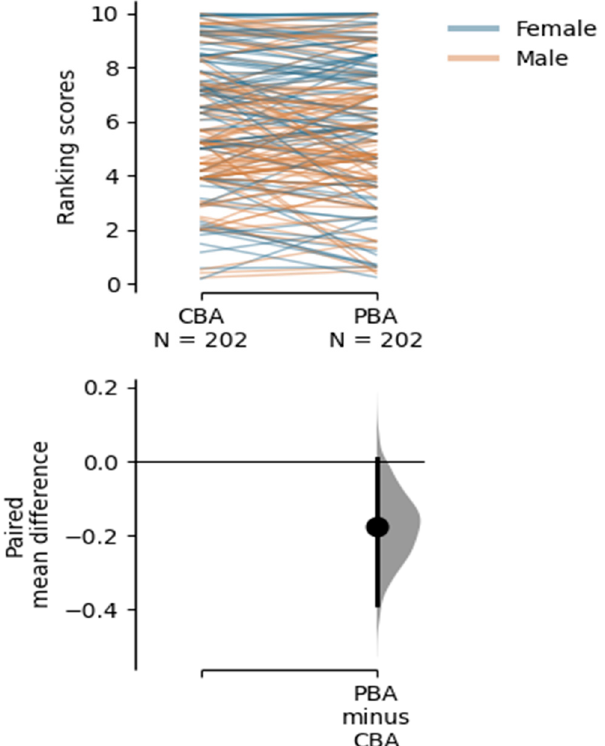
Figure 3. Gardner–Altman estimation plot for the paired mean difference between PBA and CBA scores of 202 pupils (group ALL).